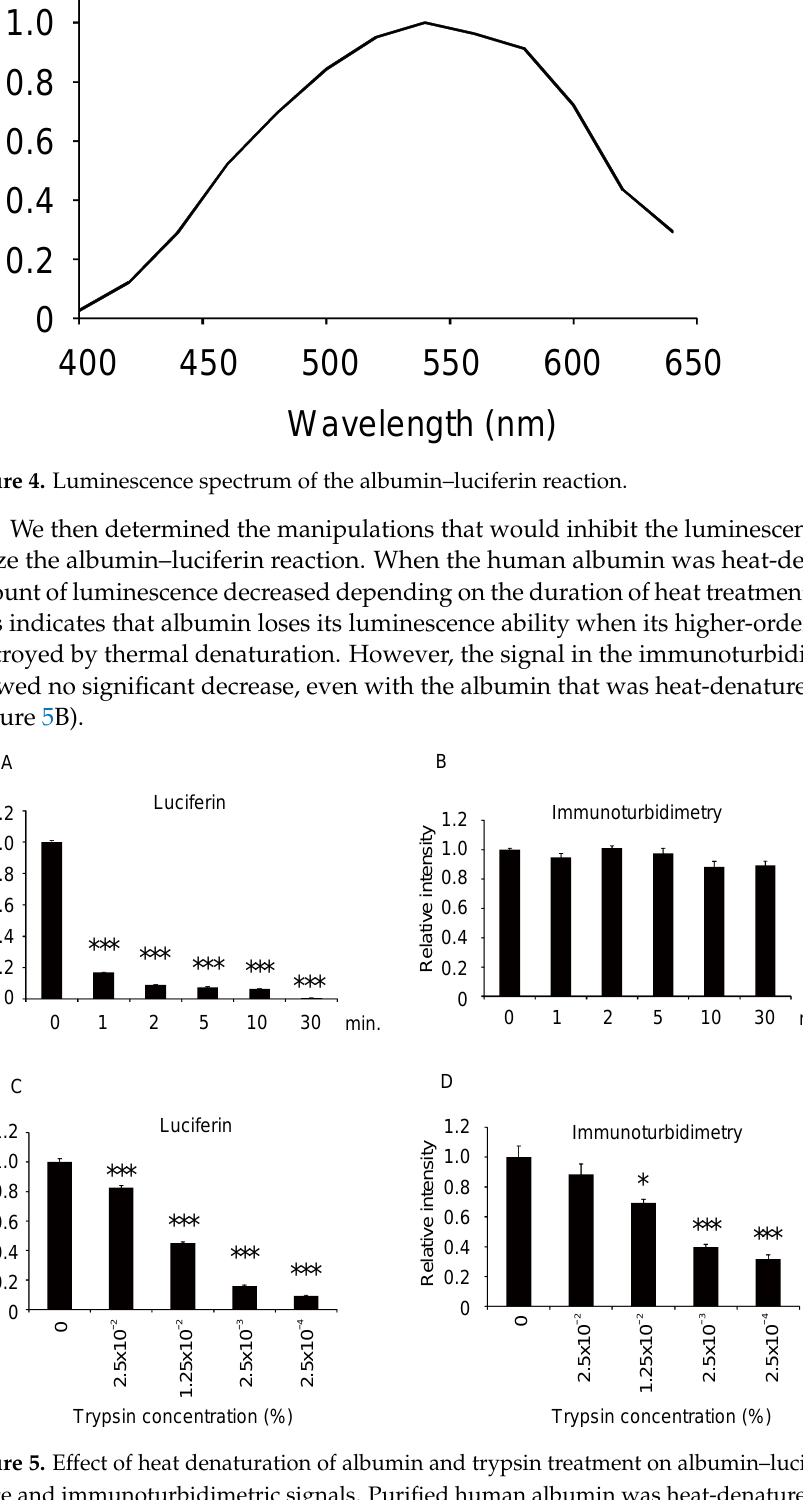
Figure 5. Effect of heat denaturation of albumin and trypsin treatment on albumin – luciferin luminescence and immunoturbidimetric signals. Purified human albumin was heat-denatured at 95 °C for each time period, and then the relative reduction in signals was measured by ( A ) albumin – luciferin reaction and ( B ) immunoturbidimetric assays. Similarly, the albumin level was measured after trypsin treatment ( C , D ). The values for each group were compared with the values of 0 min or 0% (mean ± SEM, n = 4; one- way ANOVA with Dunnett’s test, * p < 0.05, *** p < 0.001). 2.4. Detection of Albumin in the Urine of Diabetic Patients Using the Albumin – Luciferin Reaction Next, because measuring albumin levels in urine is an essential method for the di- agnosis of diabetic nephropathy, we evaluated the feasibility of using luciferin to meas- ure trace albumin levels in the urine of 20 patients with diabetes. First, we reacted the urine sample directly with luciferin and measured the luminescence. However, the quantitative results from the direct reaction between urine and luciferin revealed a low correlation with the immunoturbidimetric results (Figures 6A,B and 7A). This may be because coexisting molecules in urine inhibit the albumin – luciferin reaction. Next, we attempted to purify the protein in urine and react it with albumin to remove foreign substances in the urine. For this purpose, we used ammonium sulfate precipitation, polyethylene glycol (PEG) precipitation, and acetone precipitation.